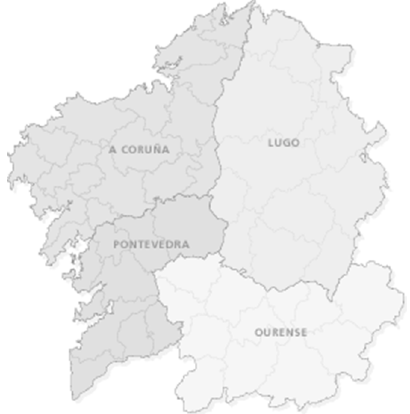
Figure 1. Galicia and the province of Pontevedra.